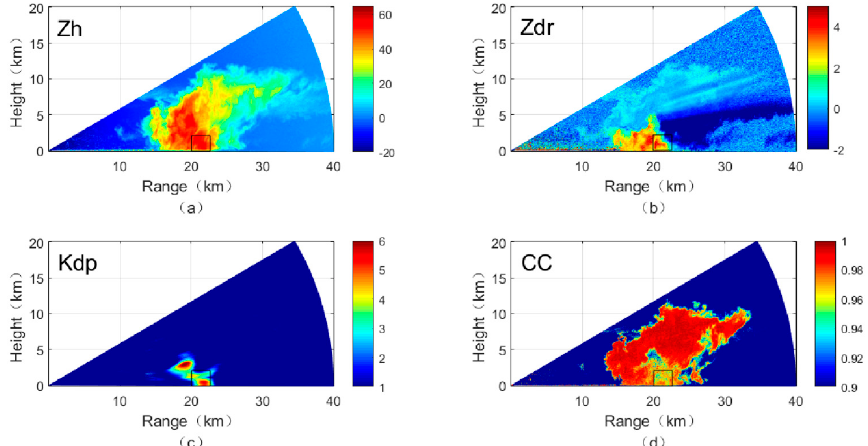
Figure 6. Range–Height Indicator (RHI) scans of dual-polarization variables: ( a ) Z h ; ( b ) Z dr ; ( c ) K dp ; and ( d ) correlation coefficient (CC) at azimuth of 31° at 20:28 UT on 30 July 2017. Black box indicates the critical area in which the downburst was generated.